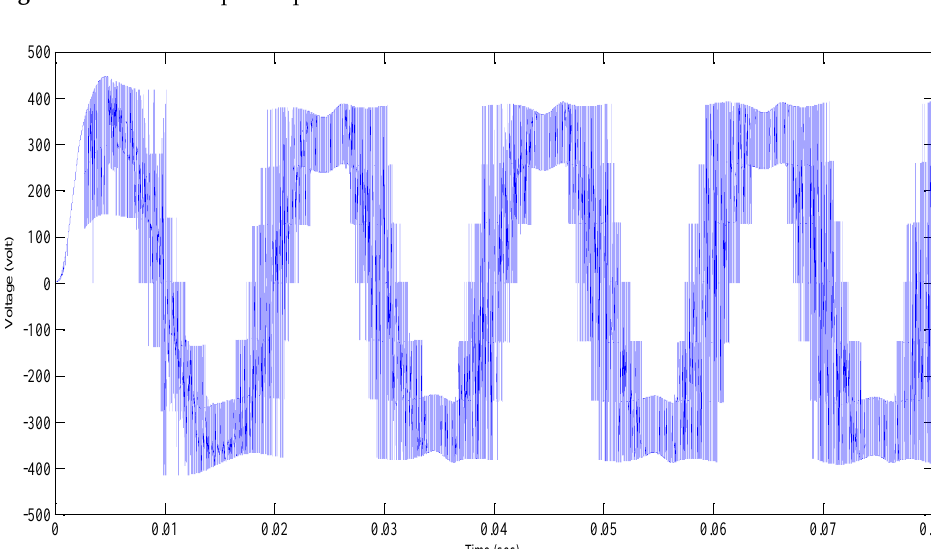
Figure 26. qZS-CHBMLI voltage output with seven levels. Table 11. THD analysis of qZS-CHBMLI at different value of m a .